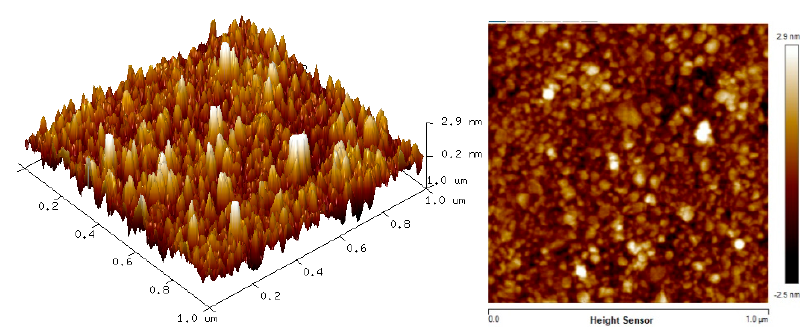
/ HGQDs thin Figure 7. AFM images of CTAB/HGQDs thin film. Figure 7. AFM images of CTAB Figure 7. AFM images of CTAB/HGQDs thin film. Figure 7. AFM images of CTAB/HGQDs thin film.